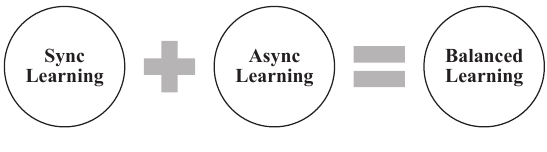
Figure 1. Showing the formula for a balanced learning